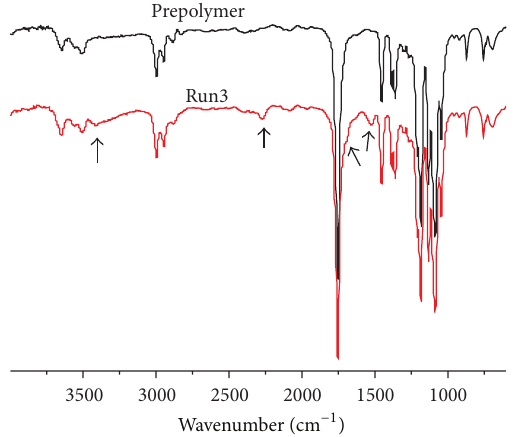
Figure 2: The infrared spectrum of the PLA prepolymer and the PLA chain extended with HDI